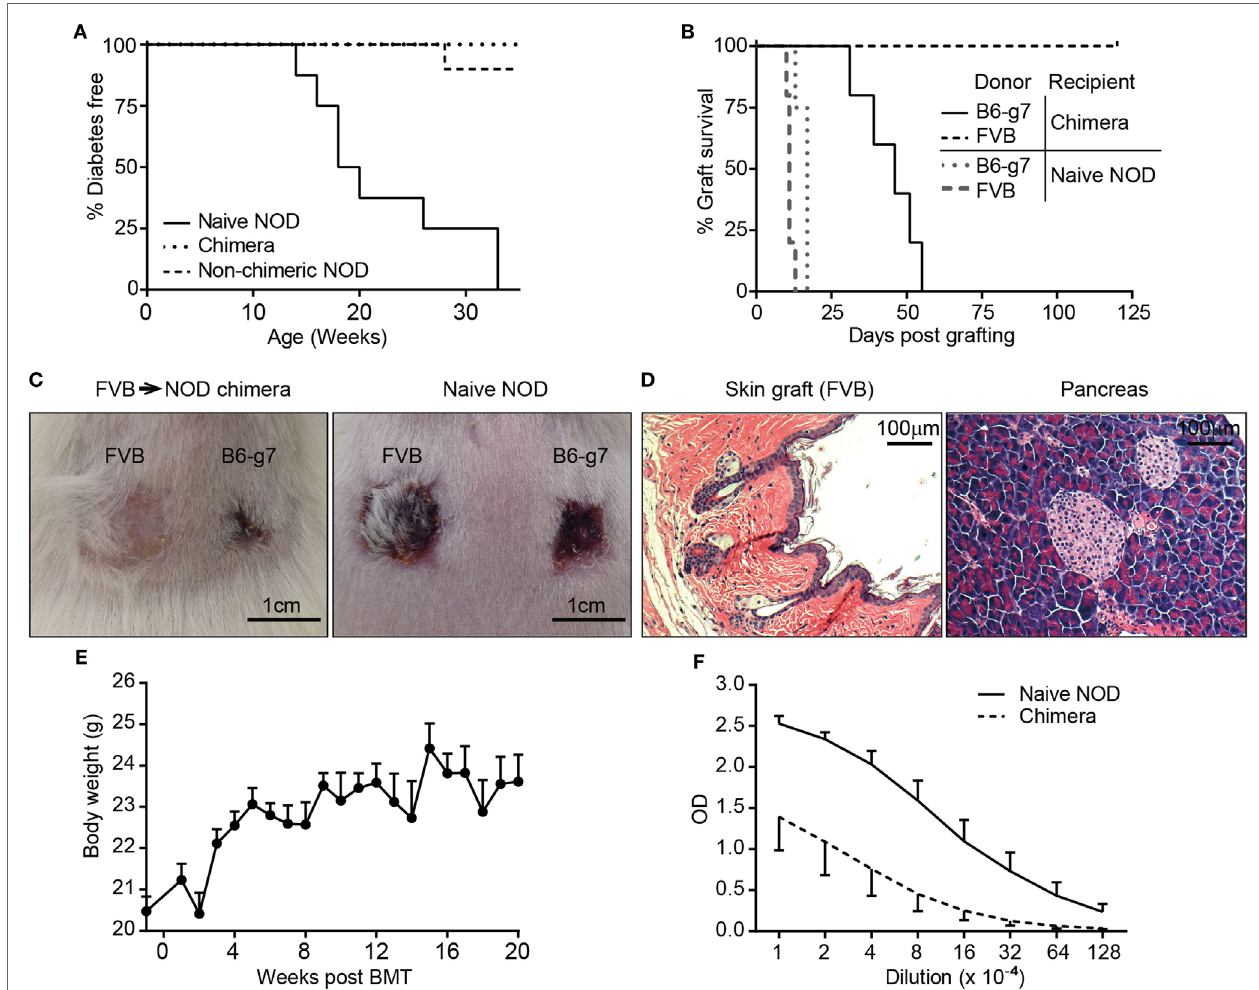
FigUre 4 | Chimeras with high level or complete chimerism acquired full donor-specific tolerance, did not develop autoimmune disease, and recovered immunocompetence. (a) Lack of autoimmune diabetes in chimeras. Recipients [C3H → non-obese diabetic (NOD) and FVB → NOD; n = 43] conditioned with duo or triple antibody protocol (refer to Figure 2a ) and naive female NOD mice were monitored for blood glucose weekly starting from 8 to 10 weeks of age. Shown are percentages of mice that were diabetes-free over time (chimeric mice, n = 31; non-chimeric mice, n = 12; naive NOD, n = 8). (B) FVB → NOD ( n = 5) and Naive NOD mice ( n = 5) were engrafted with skin from FVB and B6-g7 donors at 6 months after bone marrow transplantation (BMT). (c) Shown are representative macroscopic pictures of the acceptance and/or rejection of skin grafts in FVB → NOD chimeras (51 days postskin transplant) and naive NOD mice (13 days postskin transplant). (D) Pancreas and FVB donor skin (6 months postskin transplantation) from FVB → NOD chimeras that maintained donor chimerism for about 12 months were subjected to hematoxylin and eosin staining. Shown are representative photographs from individual chimeras ( n = 4). (e) Shown is the body weight of FVB → NOD chimeras (refer to Figure 2F ; mean ± SEM). (F) FVB → NOD ( n = 4) and Naive NOD mice ( n = 5) were immunized with ovalbumin (OVA) at 12 months after BMT. Serum was collected 3 weeks postimmunization and for anti-OVA IgG detection. Shown are optical density value (mean ± SEM) for each serum